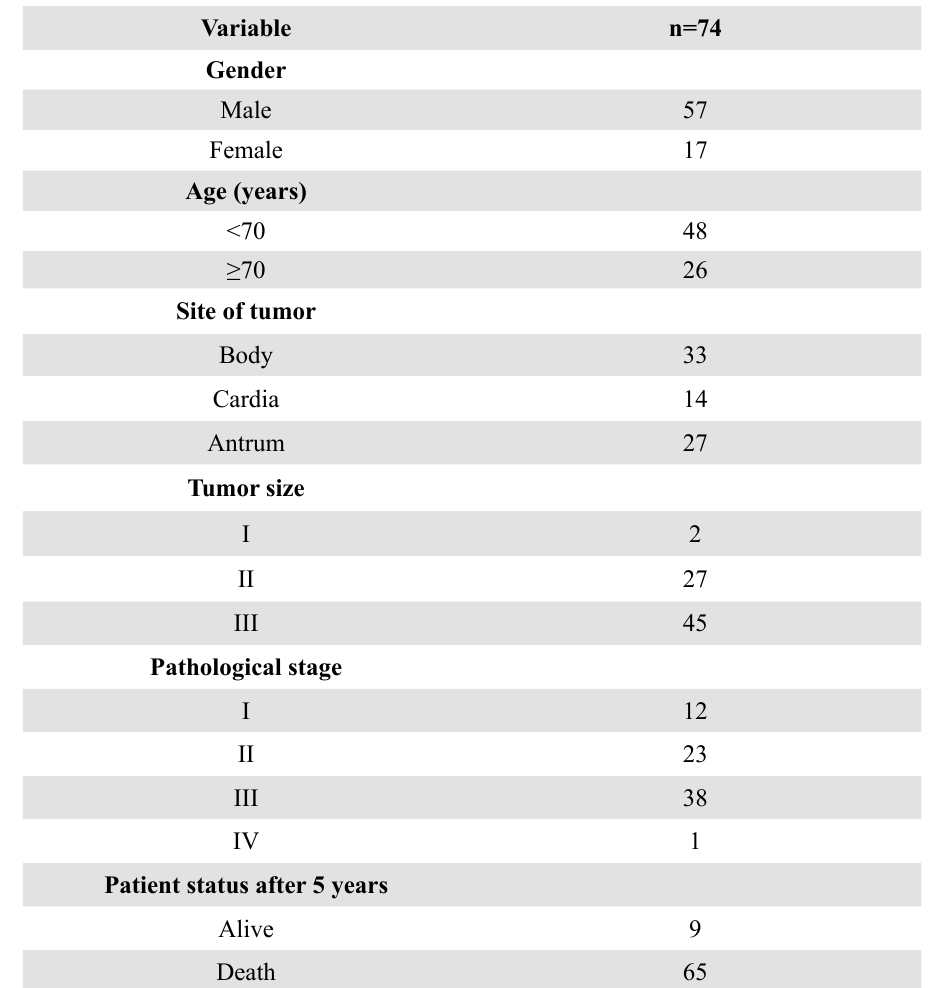
Table 1 . Patients